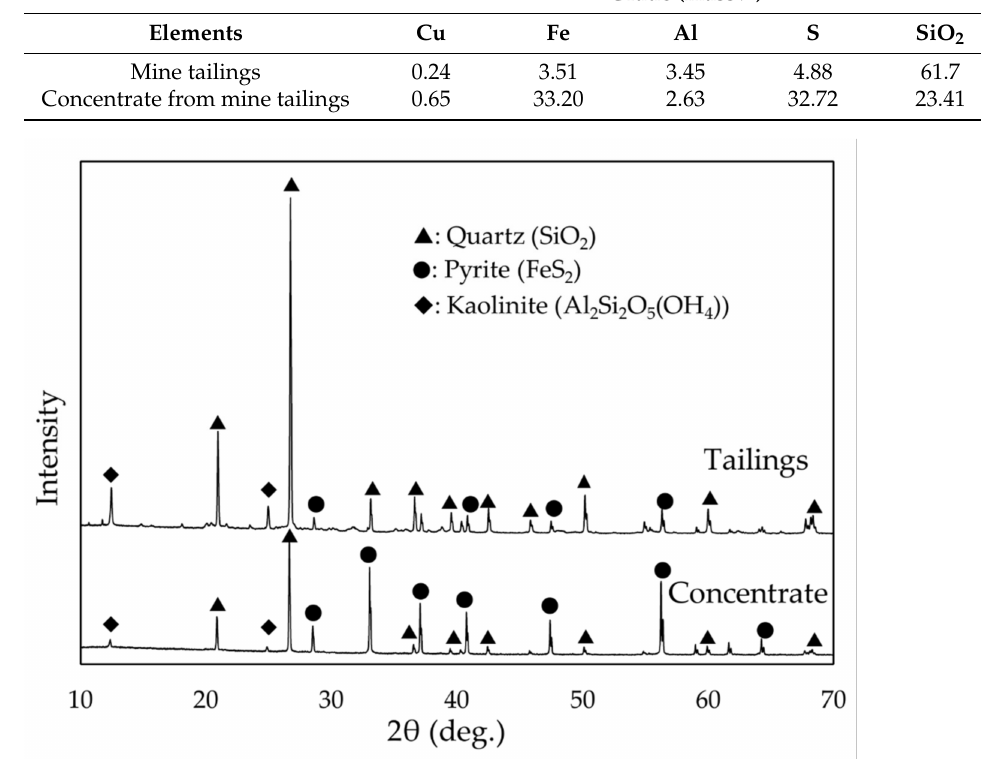
Figure 1. XRD patterns of mine tailings from Bor Copper Mine and concentrate of mine